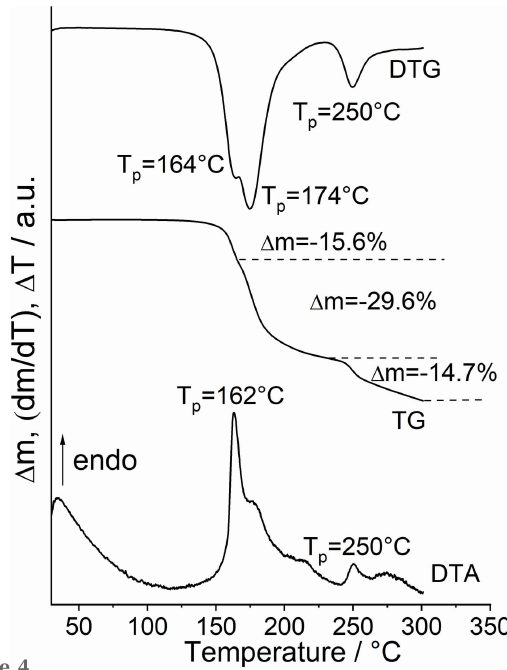
Figure 4 DTG, TG and DTA curves for the title compound measured at 8 (cid:5) C min (cid:3) 1 in a nitrogen